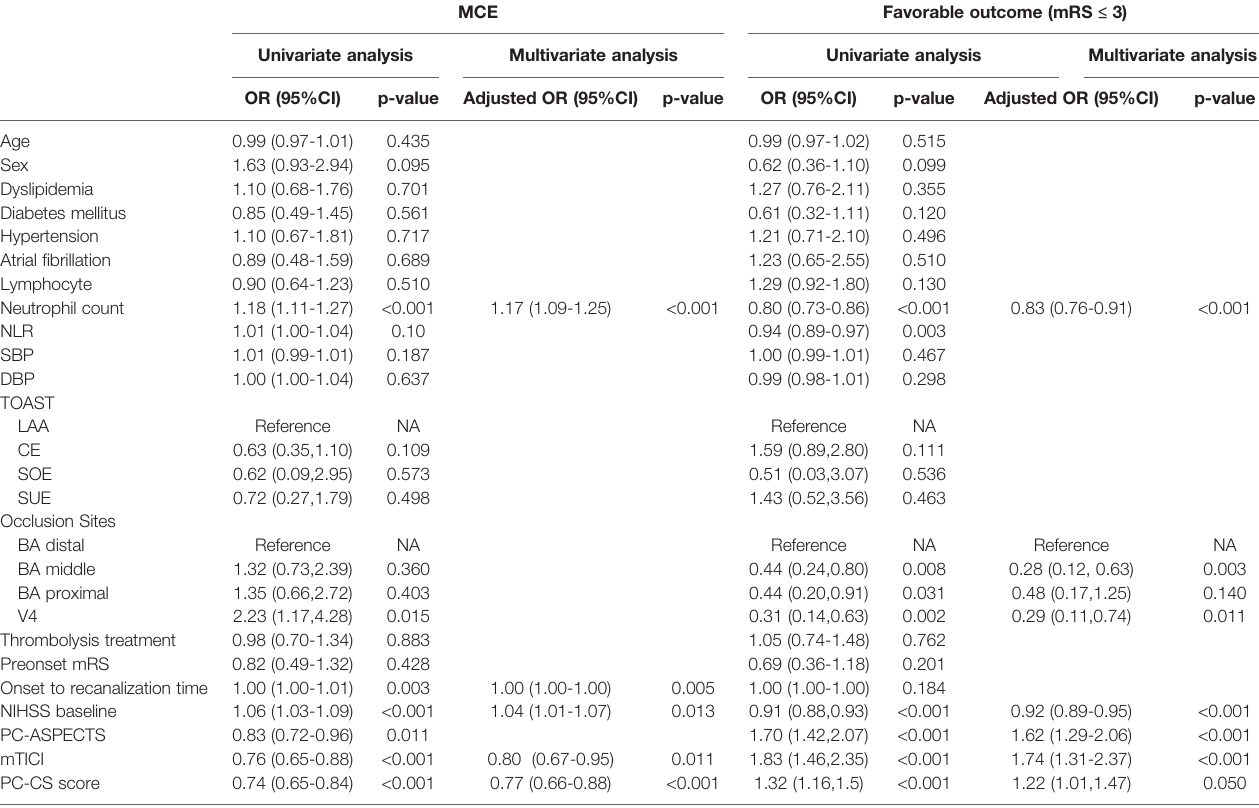
TABLE 3 | Predictors for MCE and favorable outcome (mRS ≤ 3) in enrolled ABAO patients with cerebellar infarctions treated by